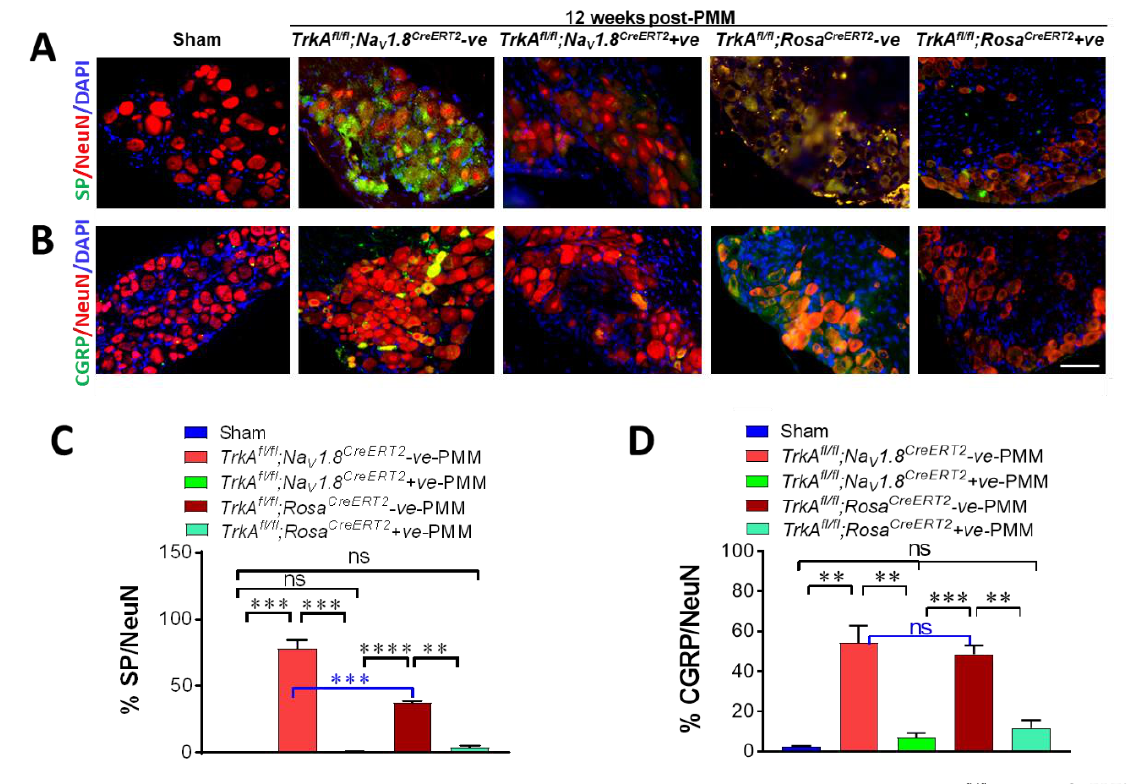
Figure 7. Sensory-neuron-specific deletion of TrkA in OA mice ( TrkA fl/fl ;Na V 1.8 CreERT2 -positive) and global deletion of TrkA in OA mice ( TrkA fl/fl ;Rosa CreERT2 -positive) reduced pain molecules substance P and CGRP significantly in DRG. ( A ) Representative immunofluorescence staining for SP (green), NeuN (red), and 4 (cid:48) ,6-diamidino-2-phenylindole (DAPI)-stained nuclei (blue) in the DRG of sham, TrkA fl/fl ;Na V 1.8 CreERT2 -negative PMM mice, TrkA fl/fl ;Na V 1.8 CreERT2 -positive PMM mice, TrkA fl/fl ;Rosa CreERT2 -negative OA mice, and TrkA fl/fl ;Rosa CreERT2 -positive OA mice. ( B ) Representative immunofluorescence staining for CGRP (green), NeuN (red), and 4 (cid:48) ,6-diamidino-2-phenylindole (DAPI)-stained nuclei (blue) in the DRG of sham, TrkA fl/fl ;Na V 1.8 CreERT2 -negative PMM mice, TrkA fl/fl ;Na V 1.8 CreERT2 -positive PMM mice, TrkA fl/fl ;Rosa CreERT2 -negative PMM mice, and TrkA fl/fl ;Rosa CreERT2 -positive PMM mice. ( C ) Quantitative analysis of SP expression in the DRG. ( D ) Quantitative analysis of CGRP expression in the DRG. Values are mean ± SEM. ** p < 0.01, *** p < 0.001, **** p < 0.0001, ns: not significant. p = 0.117 (SP sham vs. TrkA fl/fl ;Rosa CreERT2 -positive PMM), p = 0.06 (SP sham vs. TrkA fl/fl ;Na V 1.8 CreERT2 -positive PMM), p = 0.08 (CGRP sham vs. TrkA fl/fl ;Rosa CreERT2 -positive PMM), p = 0.596 (CGRP TrkA fl/fl ;Na V 1.8 CreERT2 -negative PMM vs. TrkA fl/fl ;Rosa CreERT2 -negative PMM). Scale bar: 100 µ